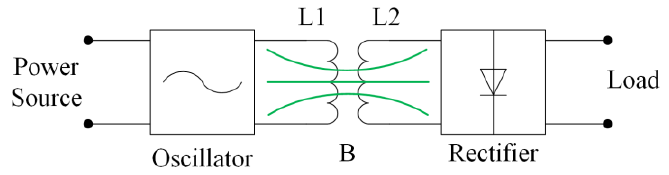
Figure 3. Basic structure schematic diagram of WPT via inductive coupled.